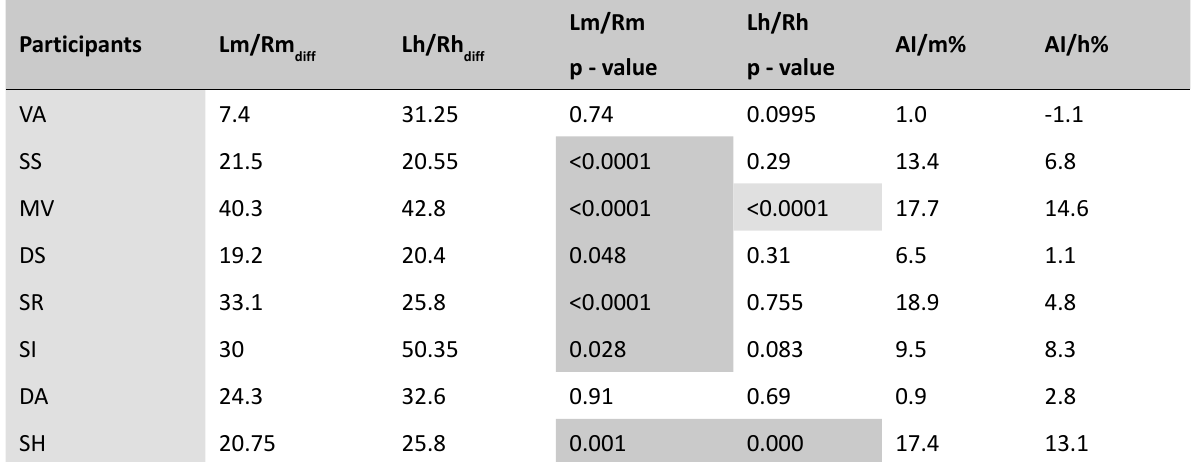
Table 3. Statistical significance in peak power difference between left and right legs, and AI for moderate and high